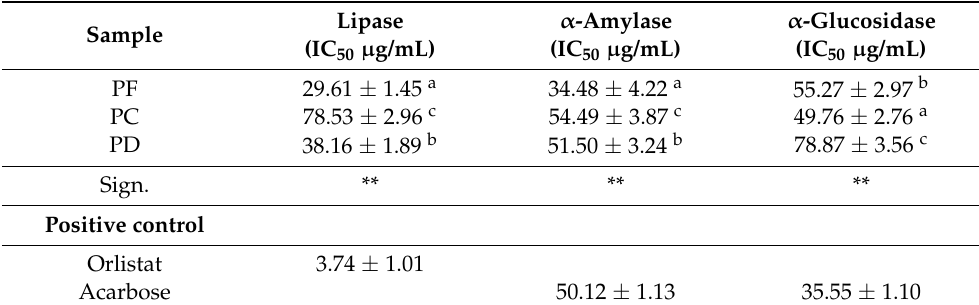
Table 6. Enzymes inhibitory activities by ‘Alimena’ myrobalan extracts.